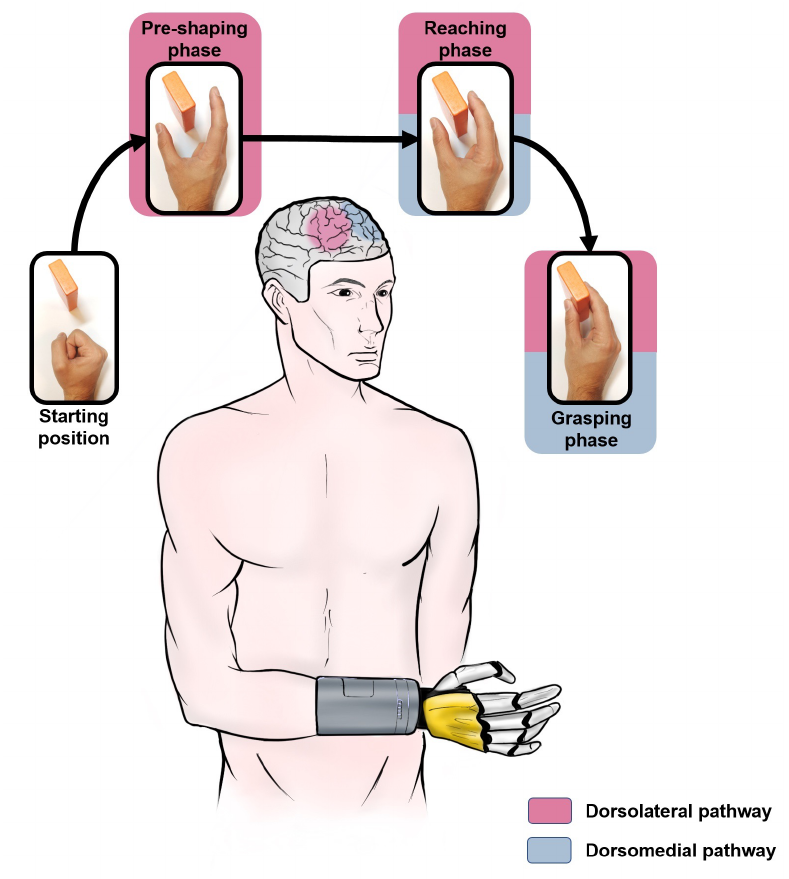
Figure 2. Activation of brain areas during